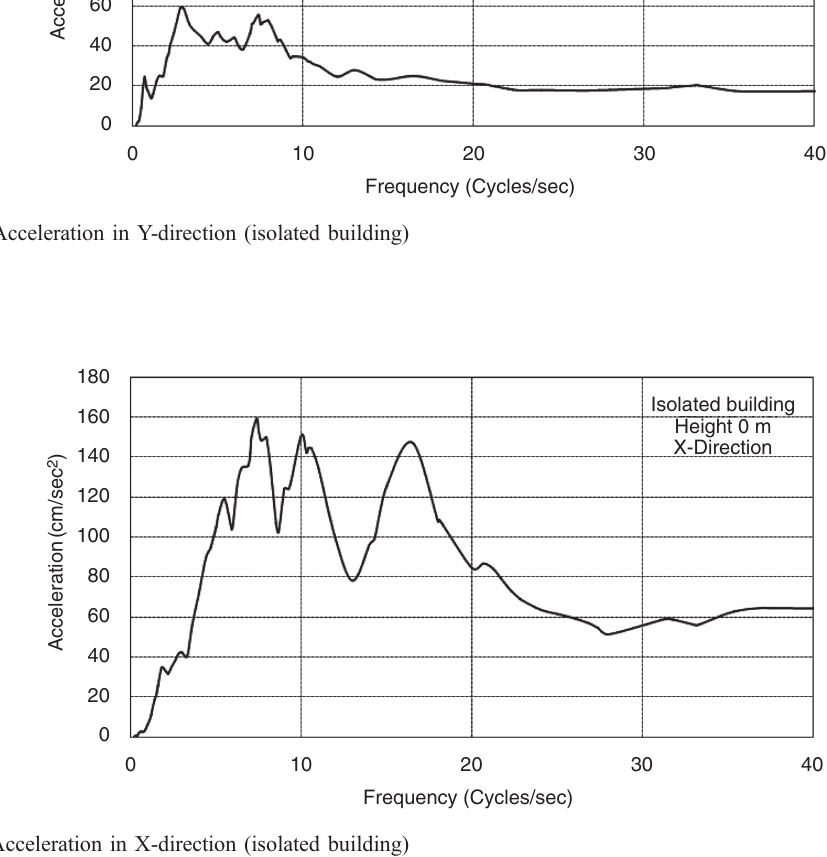
Fig. 14. Spectral Acceleration in X-direction (isolated building)